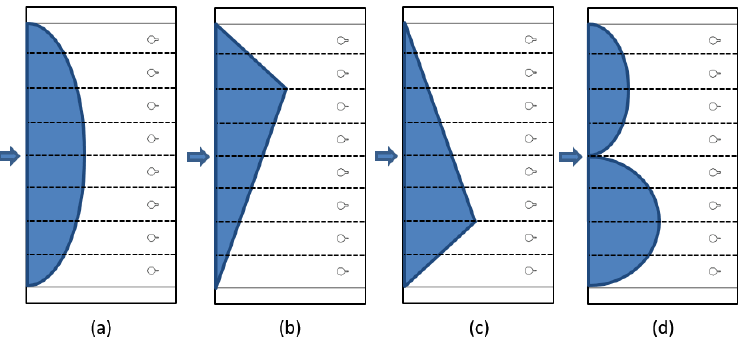
Figure 4. Flow pattern of the inlet flue gas. ( a ) Parabolic profile; ( b ) upper-skewed profile; ( c ) lower-skewed profile; ( d ) random profile; indicates ammonia injection grid (AIG) nozzle.